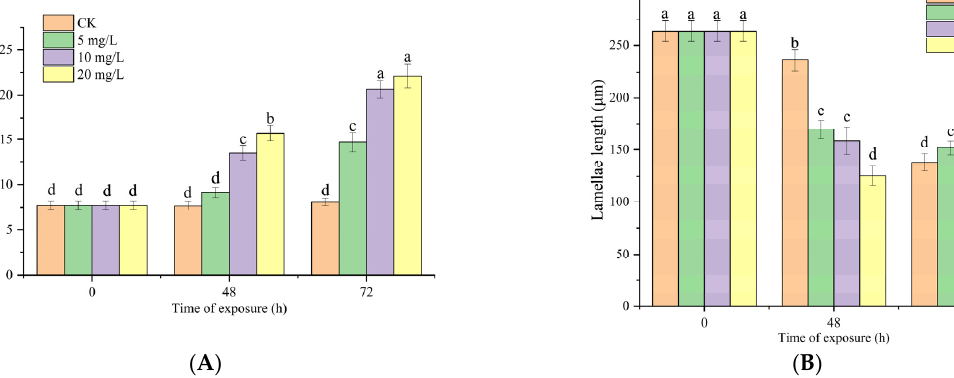
Figure 5. Quantification of fish gill structure. Epithelial cell width of gill ( A ) and lamellae length of gill ( B ) in grouper. Different lowercase letters indicate that there are significant differences among groups ( p < 0.05). groups ( p <